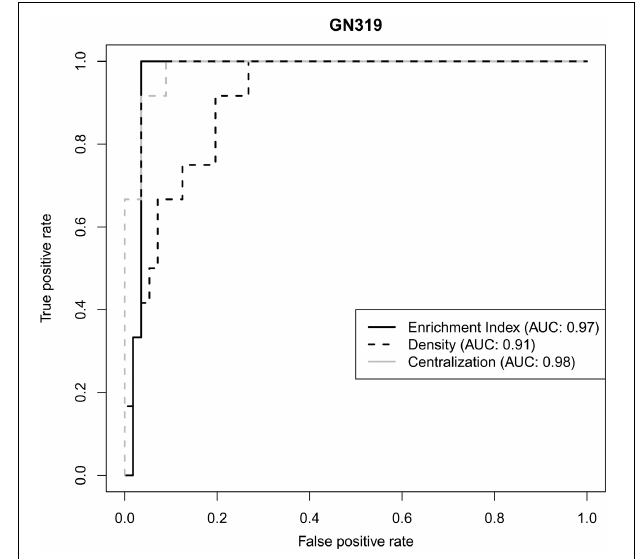
FIGURE 4 | Receiver operating characteristic (ROC) curves illustrating how 3 different network statistics discriminate genetically-driven modules from other modules in a validation